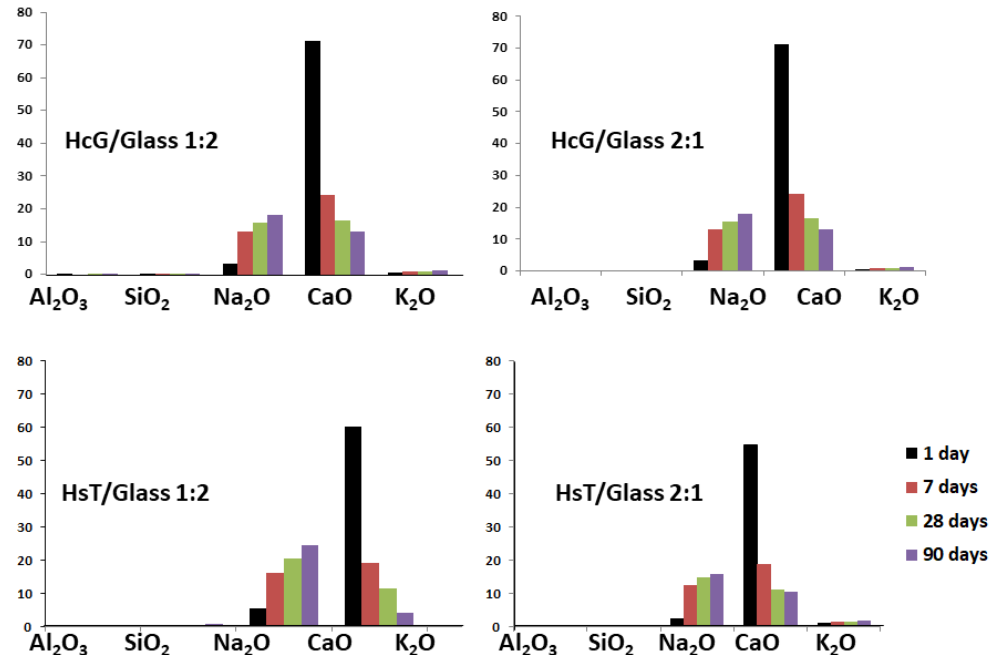
Figure 11. DSC analysis of main oxides (%) in lixiviates and their variations in the referenced